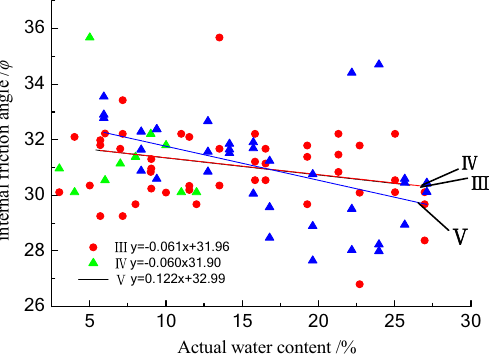
Figure 8. The relationship between the internal friction angle and moisture content.